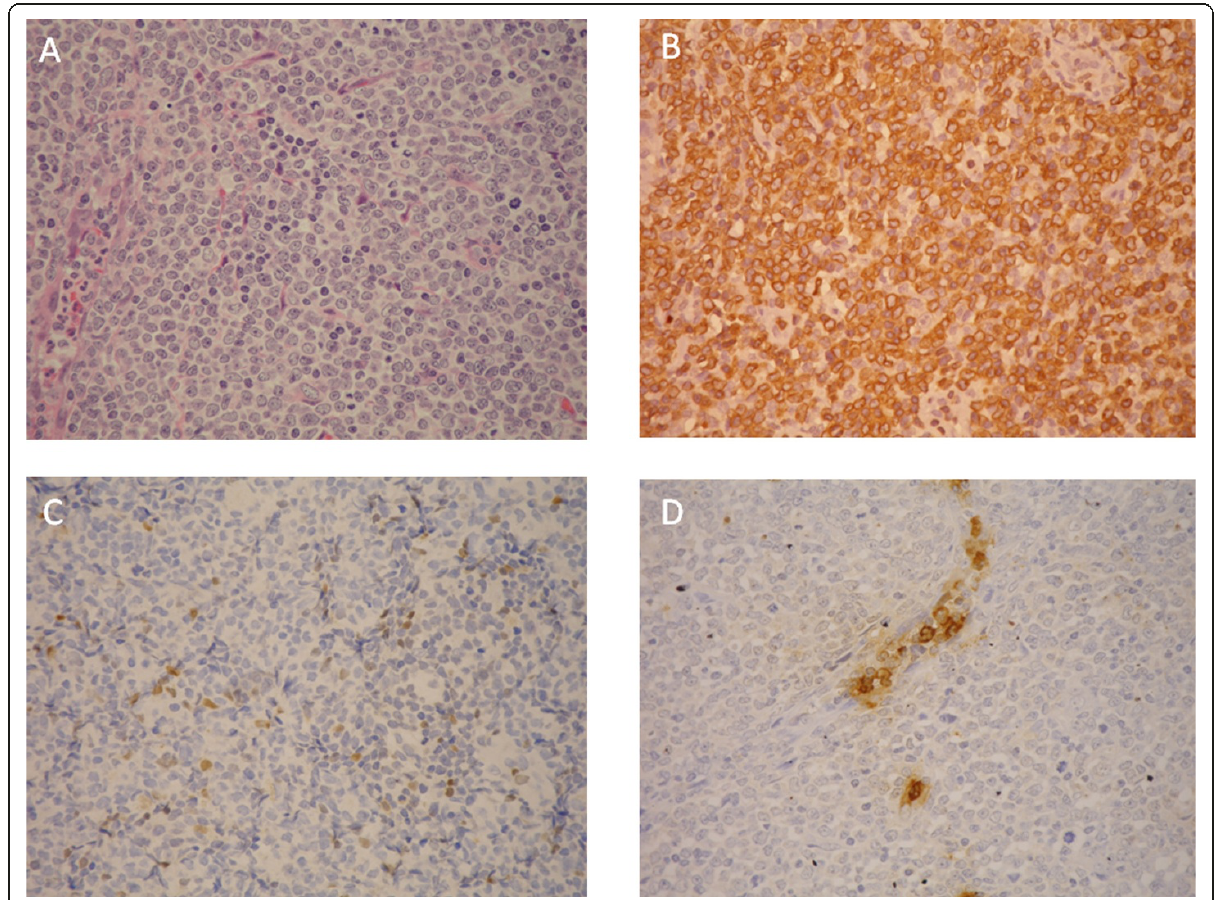
Figure 1 Histology of the lymph node biopsy. A . diffuse infiltrates of medium-sized lymphoid cells, which had fine chromatin and small nucleoli. B . tumor cells positive for CD3(Polyclonal). C .a part of tumor cells positive for TdT. D . tumor cells were negative for myeloperoxidase